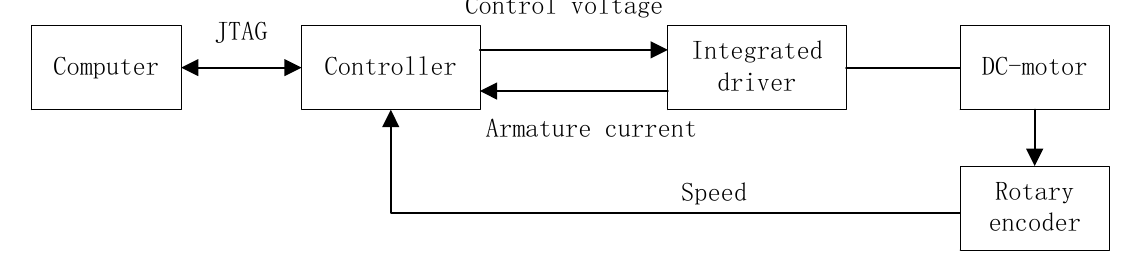
Figure 3. The topology of DC-motor test bed.